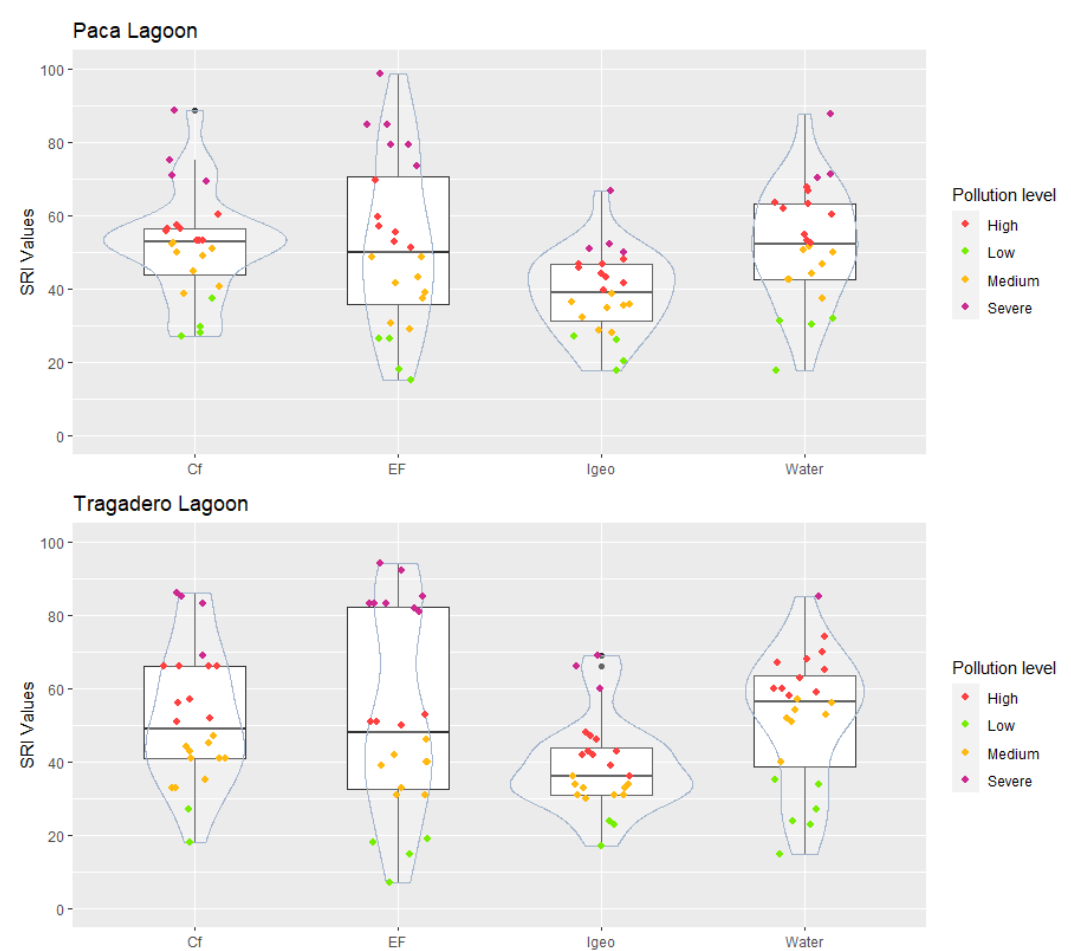
Figure 3. SRI distribution to each individual index and the concentration of metals in the surface water.